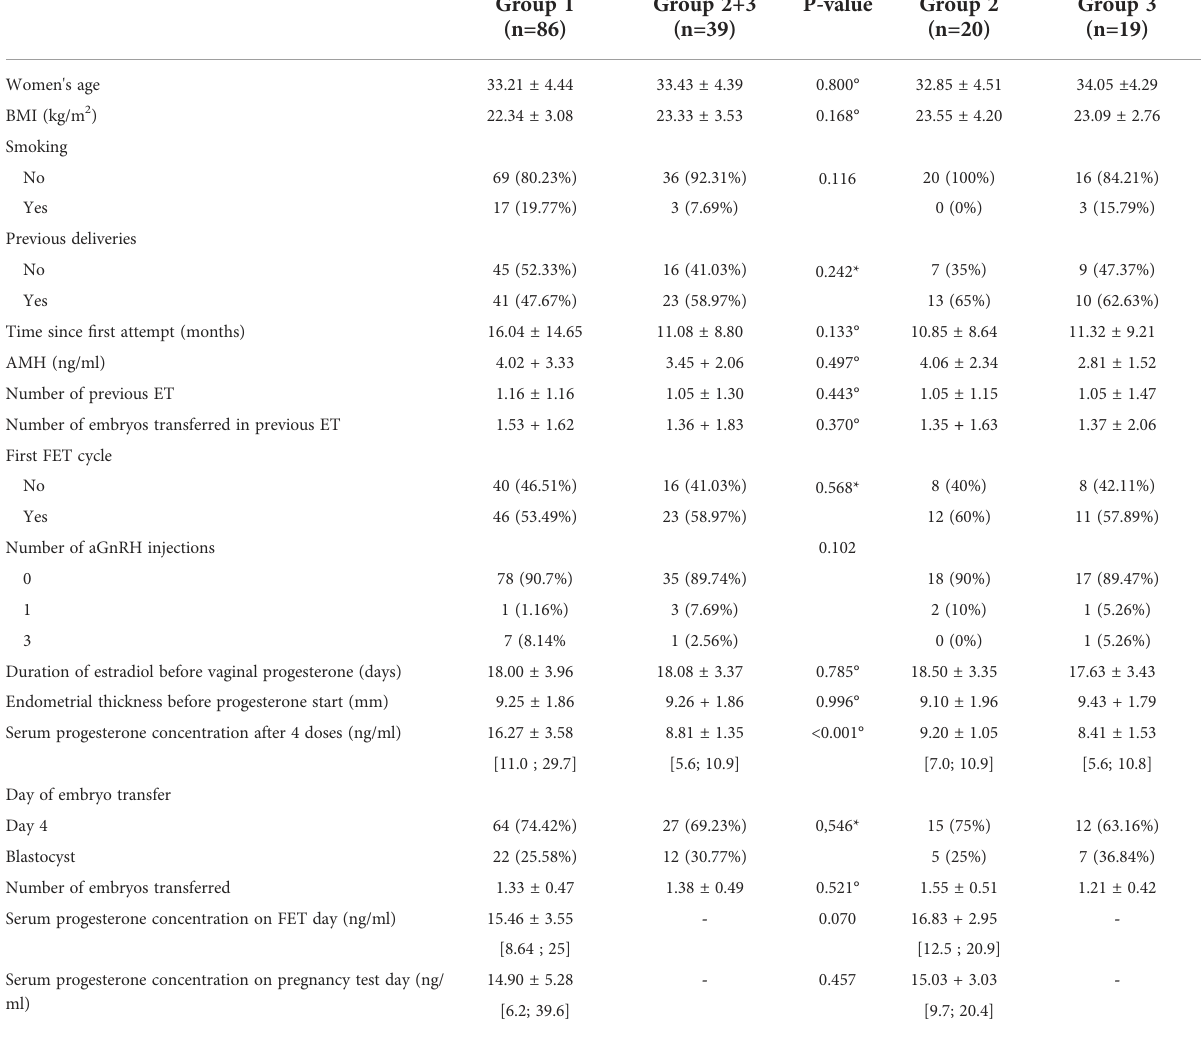
TABLE 1 Demographic and HRT FET cycle features in women with and without additional progesterone